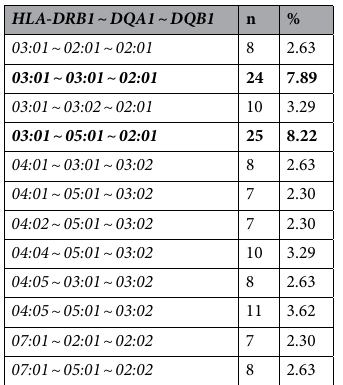
Table 5. Distribution of the HLA-DRB1 ~ DQA1 ~ DQB1 haplotypes in patients with T1D in the São Luís, Maranhão State, Brazil (> 1% of frequency). Bold indicates the most prevalent haplotypes. T1D = type 1